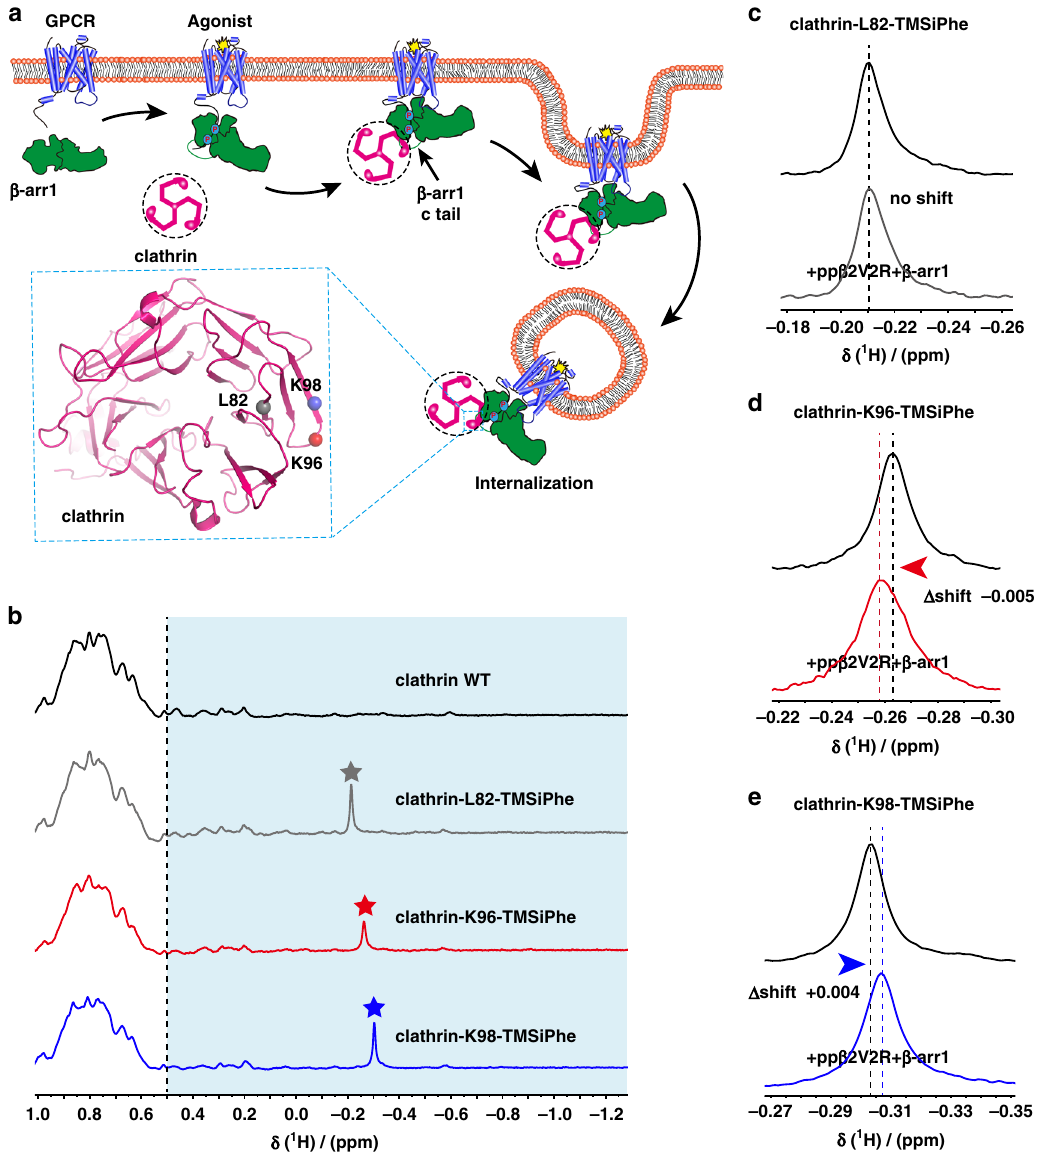
Fig. 7 Incorporation of TMSiPhe in clathrin to monitor the conformation changes. a Schematic diagram of interaction between the clathrin and arrestin during the receptor endocytosis. β -arr1 is recruited to the receptor when the receptor is activated by speci fi c agonists. The arrestin mediate receptor internalization by interacting with clathrin and AP2. The clathrin terminal domain (TD) (heavy chain) interacted with the c-tail of the β -arr1. Residues of L82, K96, and K98 are close to the arrestin/clathrin interface (clathrin crystal structure, PDB: 1BPO). The TMSiPhe-incorporated clathrin sites are depicted as spheres with different colors (gray: L82, red: K96, blue: K98). The blue circles indicate the phosphorylation. b 1D 1 H NMR spectra of clathrin labeled as described in (7a). The spectra were recorded in a buffer containing 20m M HEPES (pH = 7.5) 150m M NaCl and 10% D 2 O at 25°C using a Bruker 950MHz NMR spectrometer. The protein concentrations were 10 μ M , and the total recording time per spectrum was 18min. The chemical shift for the TMSiPhe protein was < − 0.1 ppm. c – e 1D 1 H NMR spectra of clathrin alone and incubation with ISO-pp β 2V2R/ β -arr1 complex. Clathrin-L82-TMSiPhe displayed no chemical shift in response to the incubation with the pp β 2V2R/ β -arr1 complex. The clathrin-K96-TMSiPhe and clathrin-K98-TMSiPhe showed low- fi eld shift ( △ shift = − 0.005ppm) and high- fi eld shift ( △ shift = + 0.004ppm), respectively. The buffer used for the experiment contained 20m M HEPES, 150 m M NaCl, 0.01% LMNG, 0.002% CHS, and 10% D 2 O (pH = 7.5 at 25°C). The spectra were recorded using a Bruker 950MHz NMR